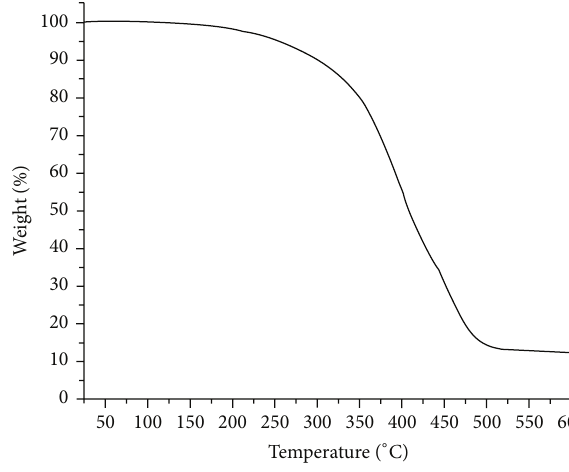
Figure 11: TGA thermogram of HBPE-St85.